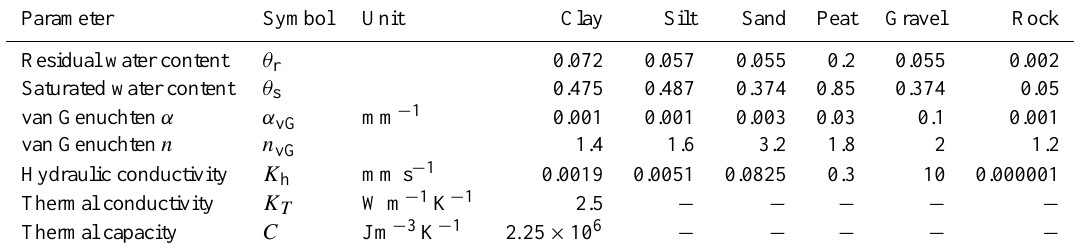
Table 2. Parameters of the different ground types. In the sensitivity analysis, the hydraulic parameters are assumed to change by ± 20% for θ sat , ± 10% for θ res , ± 50% for n vG and ± 25% for α vG , and goes from 0.01 to 100 times the original value for K h . The thermal conductivity changes by 50% and the heat capacity changes by 20% as shown in Table 3). The values are modified by the respective factors presented in Table 3. Parameter Symbol Unit Clay Silt Sand Peat Gravel Rock Residual water content θ r 0.072 θ